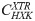
A well-determined control of HXK over XTR.(A) The mean control coefficient of HXK over XTR is negative after constraining the inferred ranges of only 3 parameters. (B) Distribution of the control coefficient CHXKXTR. (C) The inferred ranges of σnadh_cXRI,σpi_mASN, and σt3p_cTPI that determined the negative control of HXK over XTR.